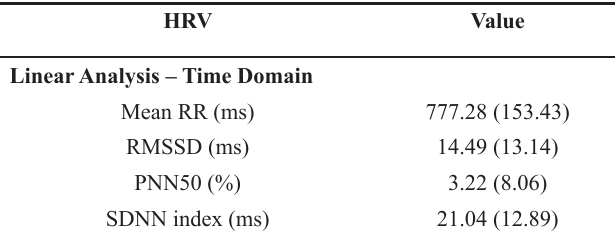
TABLE 1 - Characterization of Heart Rate Variability in participants with Chronic Renal Failure on hemodialysis (n =